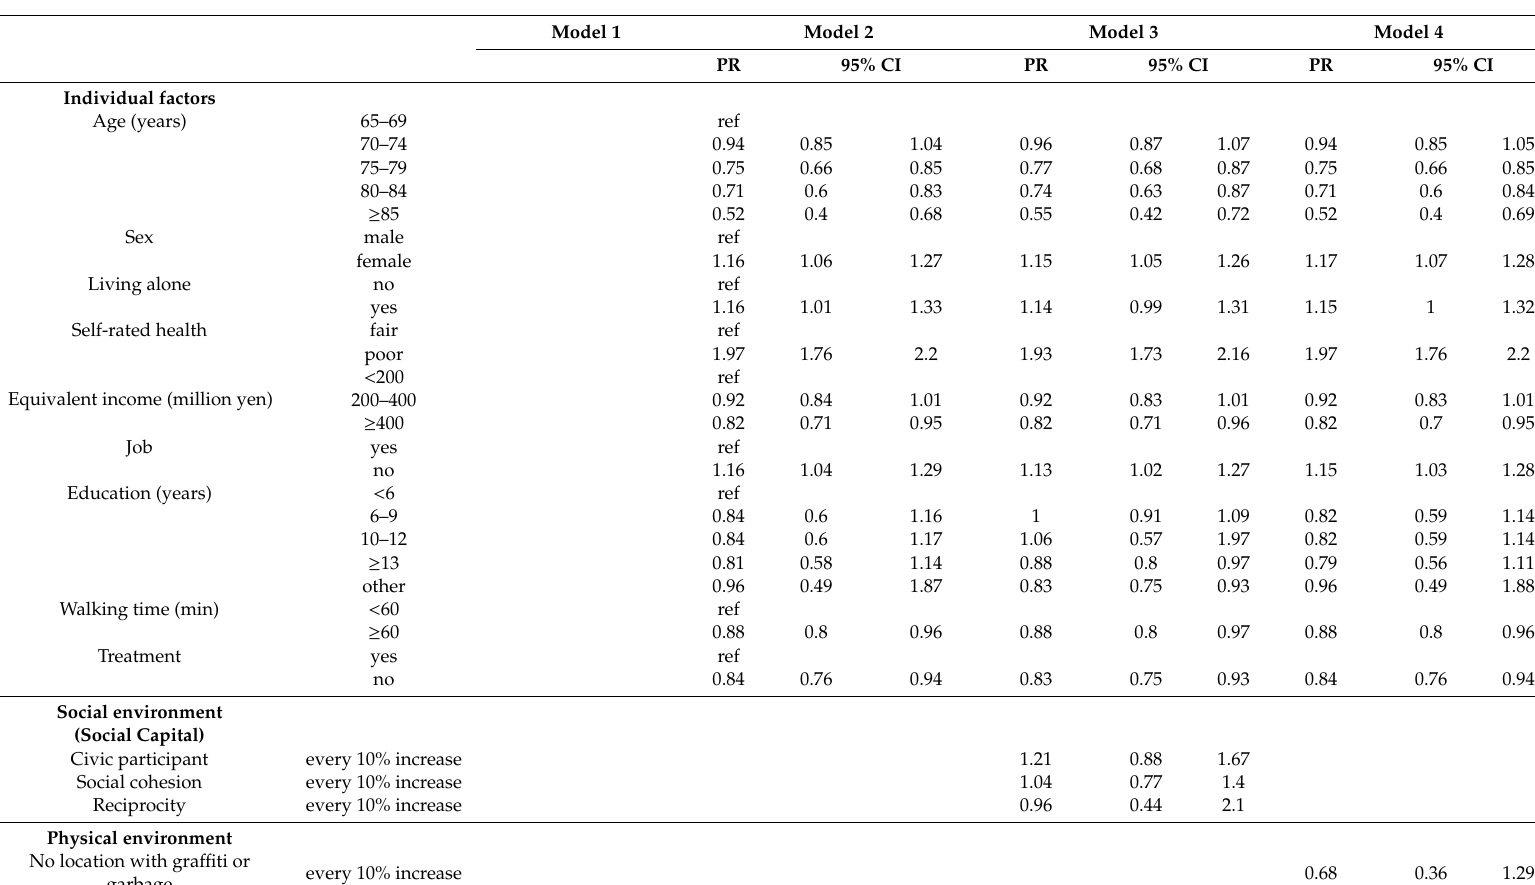
Table 4. Results of the multi-level Poisson regression analysis to study the association between neighborhood environment and sleep quality in non-depressive participants (Geriatric Depression Scale Score of <